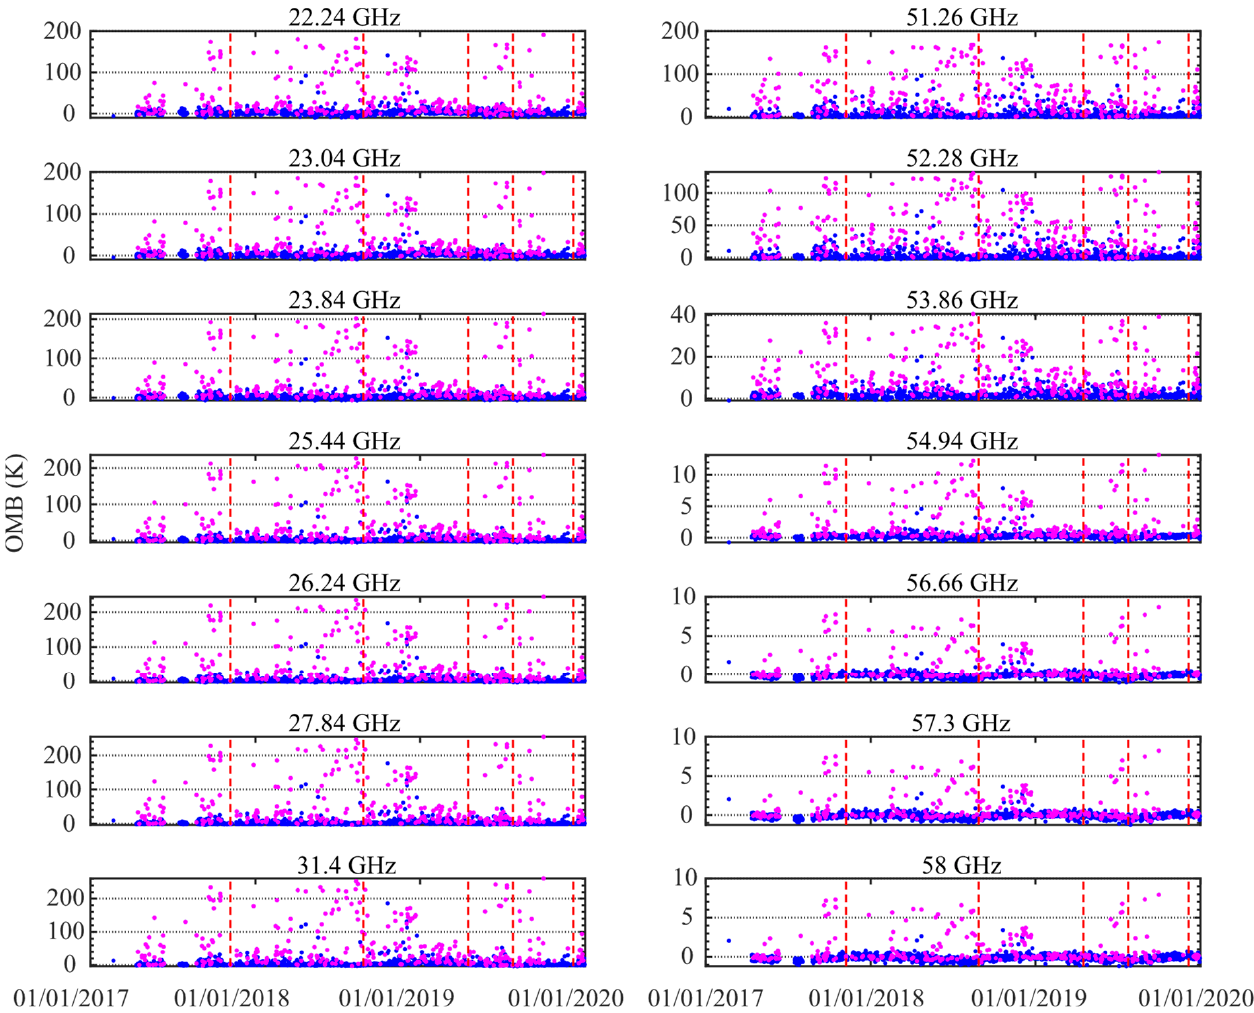
Figure 1. Time series diagrams of OMB of 14 channels, where the pink dots are precipitation times, the blue dots stand for non-precipitation times, and the red dashed lines represent the dates of MWR calibration (7 November 2017, 28 August 2018, 17 April 2019, 25 July 2019, and 6 December 2019).